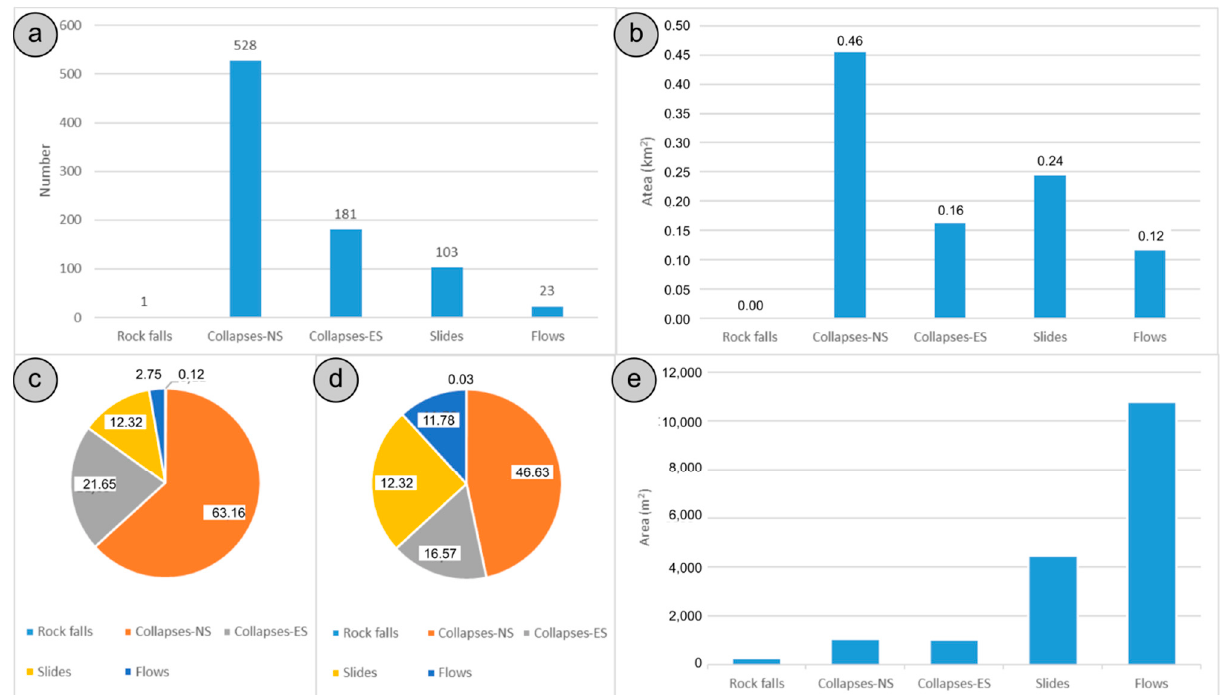
Figure 10. Distribution of areas and number of landslides by typologies: ( a ) total number; ( b ) total area (km 2 ); ( c ) % in number; ( d ) % in area; ( e ) individual areas.